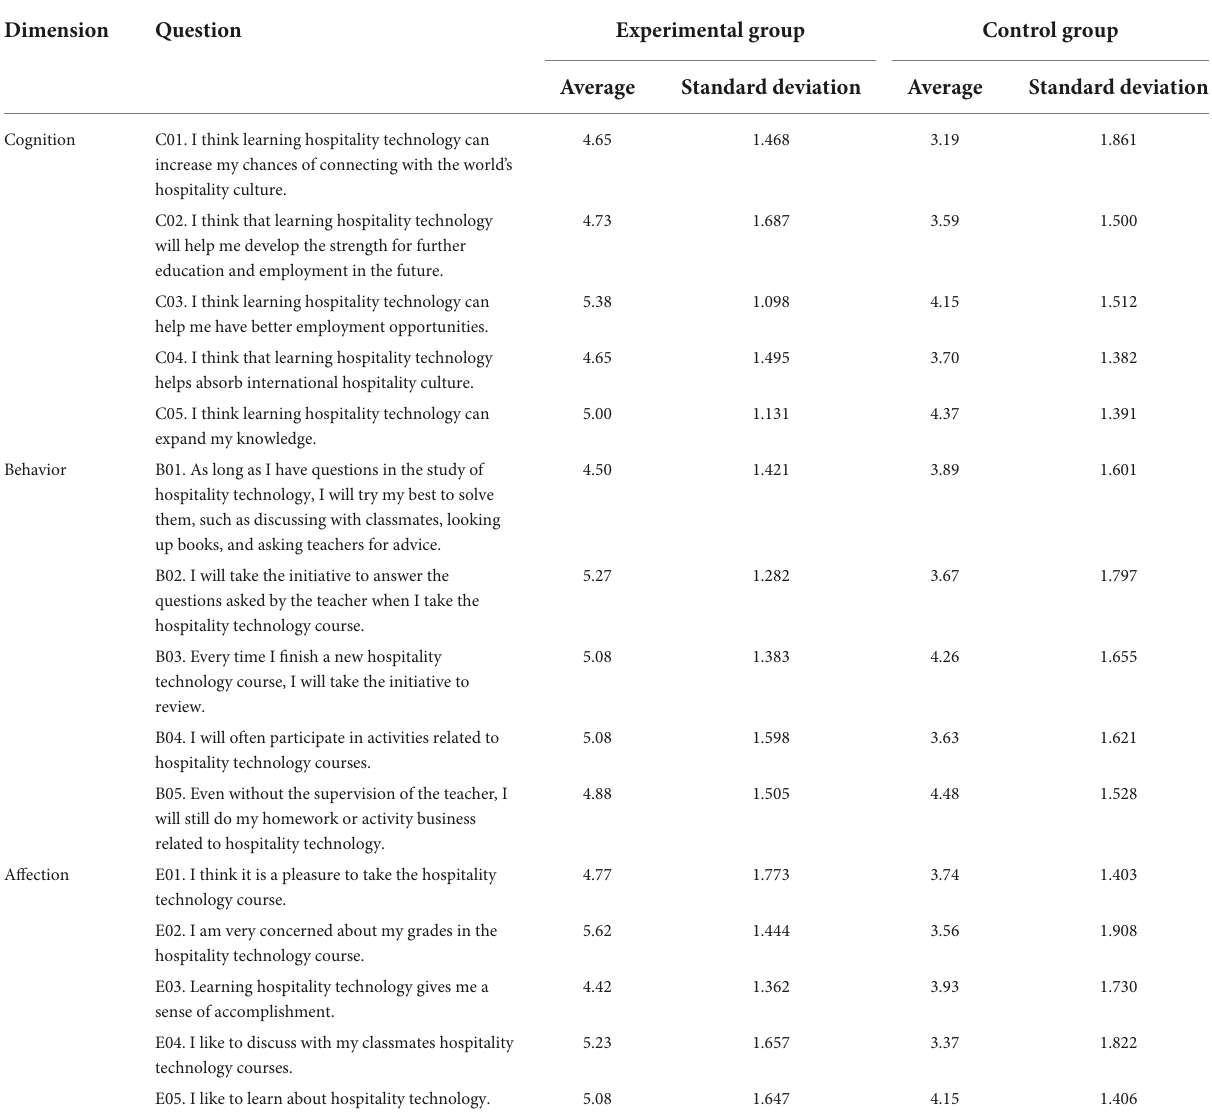
TABLE 9 The statistical analysis of pre-test results in different dimensions of learning attitude. Dimension Group Number of people Average Standard deviation T -value Cognition Experimental group 26 Control group 27 Behavior Experimental group 26 Control group Experimental group 26 Control group 27 TABLE 10 The statistical analysis of post-test results in different dimensions of learning attitude. Dimension Question Experimental group Control group Average Standard deviation Average Standard deviation